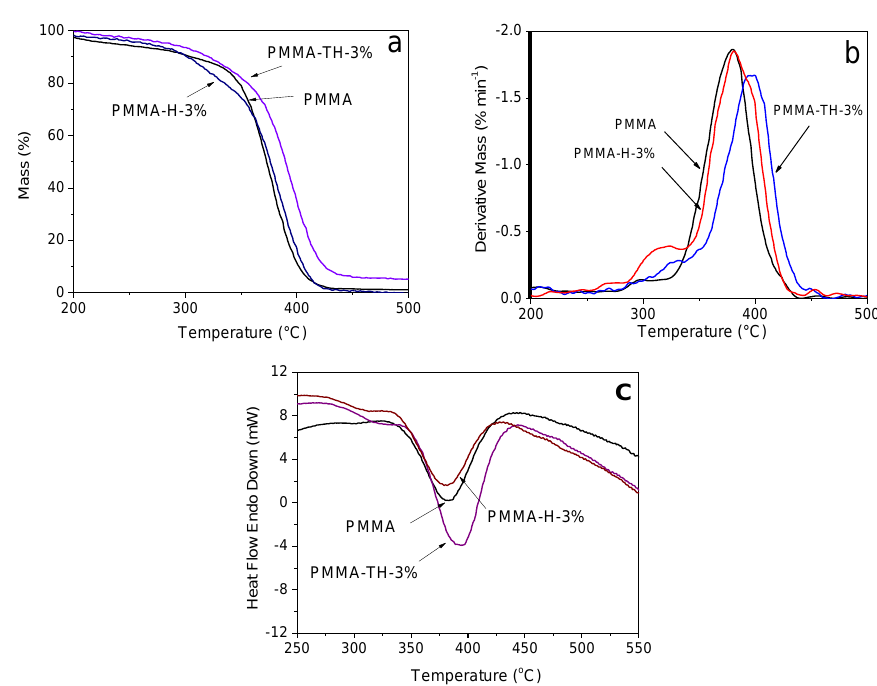
Figure 7. ( a ) TGA, ( b ) DTG, and ( c ) DTA curves of PMMA and PMMA/reactive halloysite nanocomposite. Table 2. The decomposition temperatures of the samples at 5 wt % and 10 wt % loss.